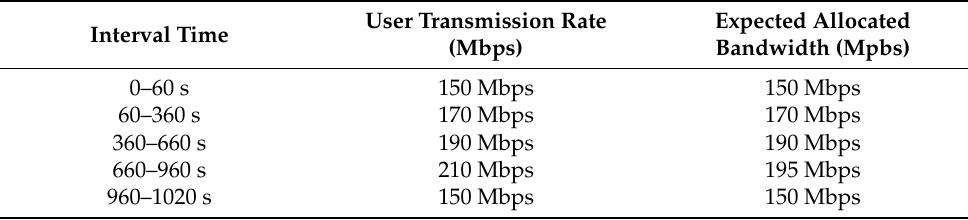
Table 3. Demanded and received bandwidth for the premium flexible Internet